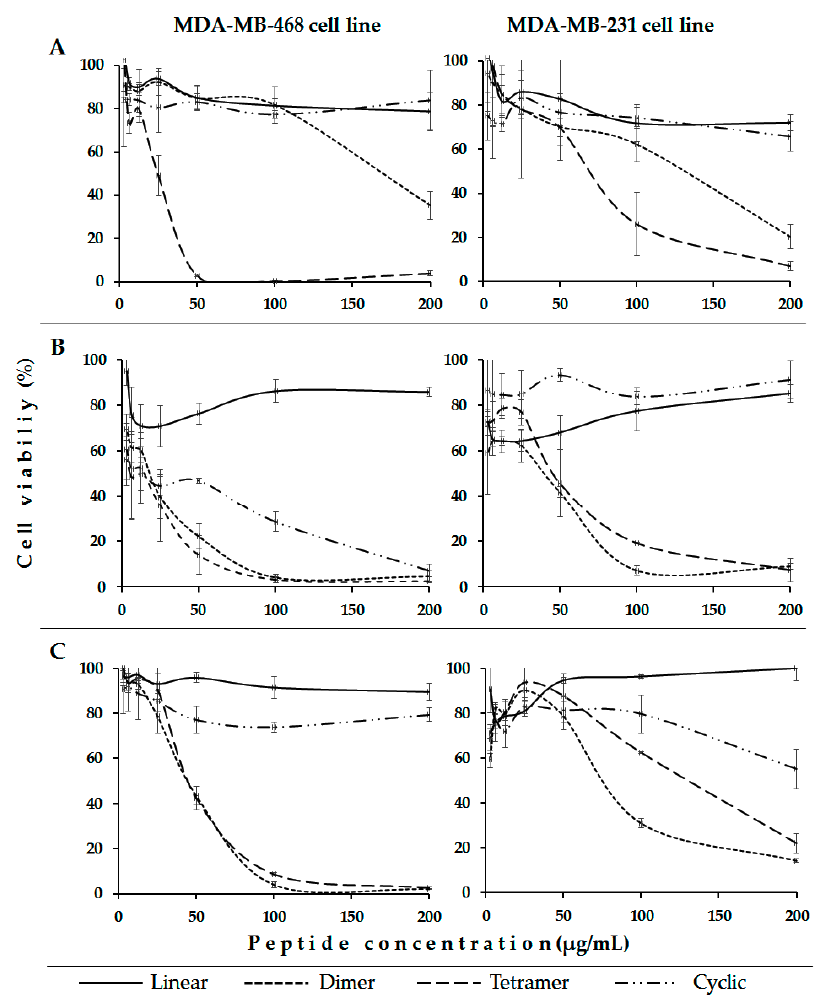
Figure 3. Cytotoxic effect of LfcinB-derived peptides against MDA-MB-468 ( left ) and MDA-MB-231 ( right ) breast cancer cell lines. Cytotoxic effect, after 2 h incubation time, of each designed peptide (Table 2) at different concentrations can be observed. LfcinB (20–25) family ( A ); LfcinB (20–30) family ( B ) and [Ala 19 ]-LfcinB (17–31) family ( C ). The data are expressed as the mean ± S.D. ( n = 3). Statistically significant differences were found in both cell lines at 100 µg/mL for: LfcinB(20–25) 4 cf LfcinB (20–25), panel A; LfcinB(20–30) 4 and LfcinB (20–30) 2 cf LfcinB(20–30), panel B; and [Ala 19 ]-LfcinB (17–31) 4 and [Ala 19 ]-LfcinB (17–31) 2 cf [Ala 19 ]-LfcinB (17–31), Panel C. (ANOVA, Post hoc Bonferroni, p < 0.05).